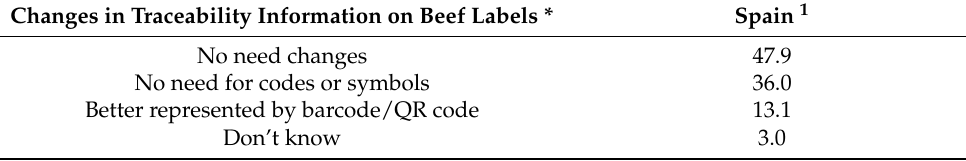
Table 6. Opinion of Spanish consumers according to changes in the traceability information on beef